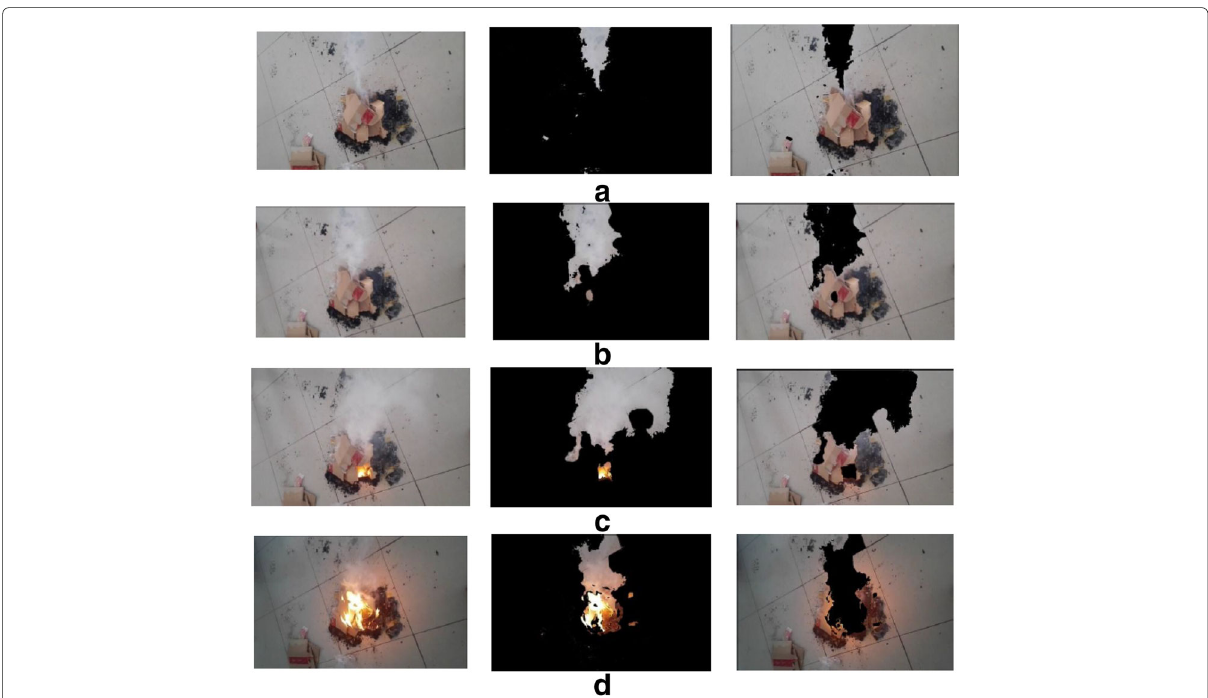
Fig. 6 a – d Fire segmentation results (from left to right is the original image, the foreground, and the background) will have a corresponding change; it can be easy for recognition and segmentation, so it can be used for fire protection systems in real-time